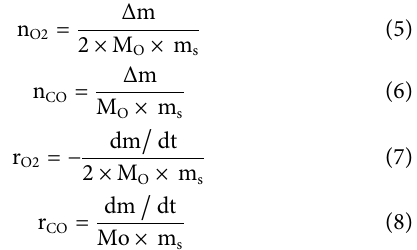
Figure 1 illustrates the XRD patterns of La 0.7 Sr 0.3 Mn 0.9 X 0.1 O 3 [X = Mn (non-substituted LSM), Co-substituted LSM, and Ce- substituted LSM] at room temperature in the 2 θ range. The XRD data for the other samples are shown in Supplementary Figure S1 . The lattice parameters and space groups of the synthesized La 0.7 Sr 0.3 Mn 0.9 X 0.1 O 3 were determined by Rietveld re fi nement. All diffraction peaks assigned to the crystalline phase